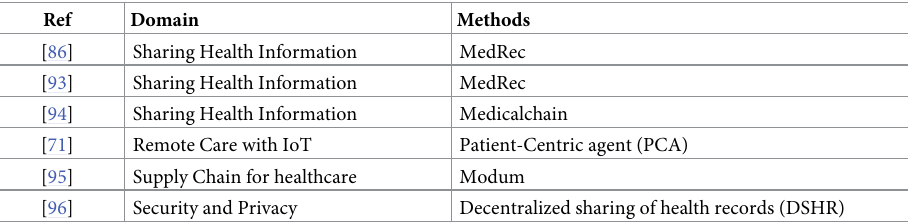
Table 2. Blockchain-based healthcare